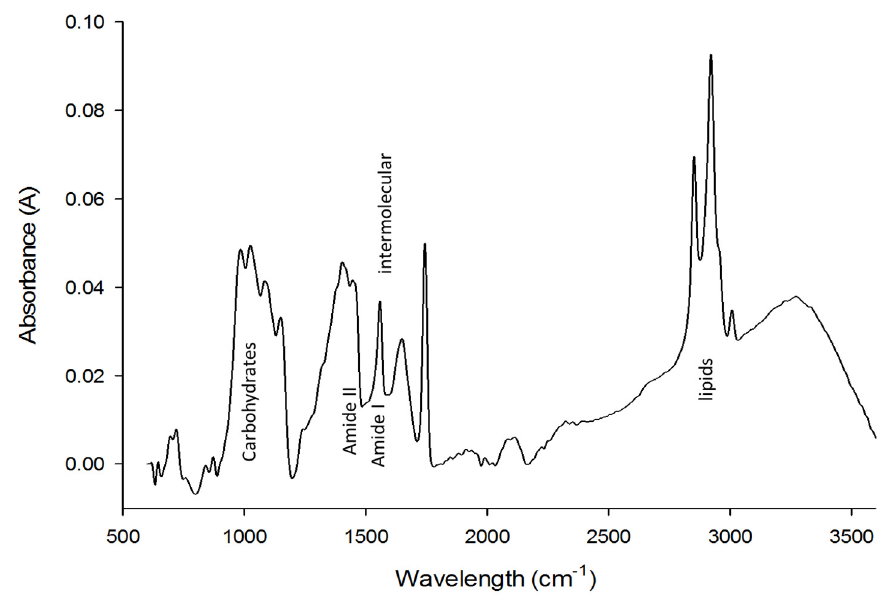
Figure 1. FT-IR spectra of the pericarp.